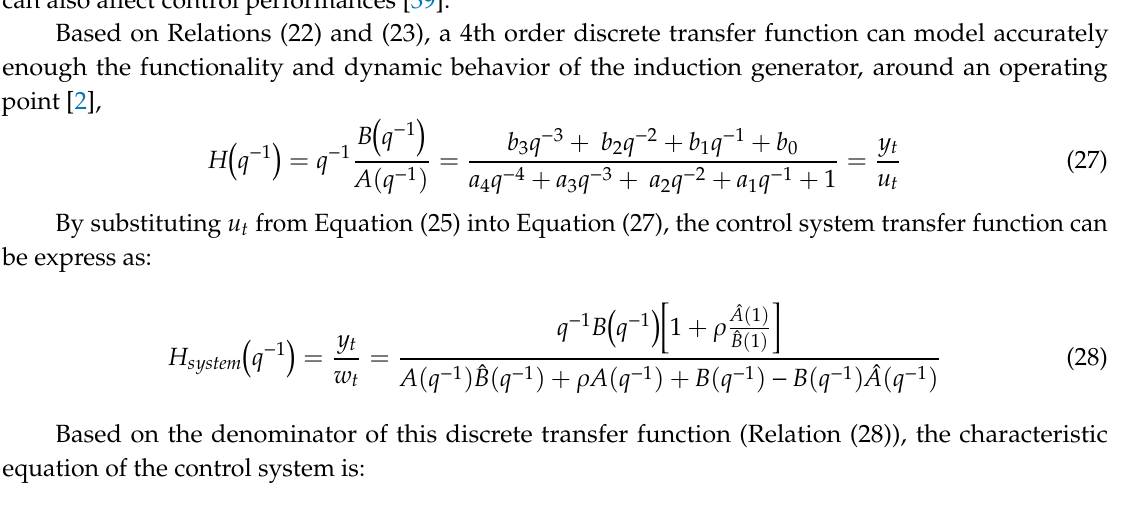
Figure 3. The minimum variance control law ( A